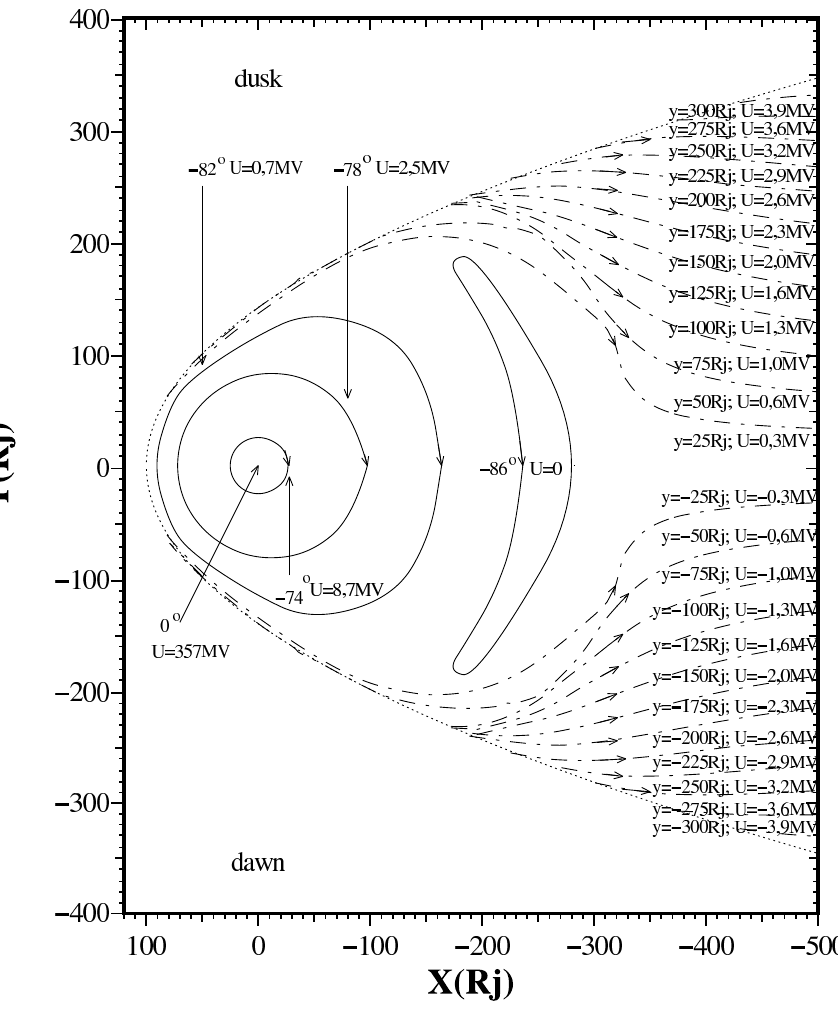
Fig. 12. Equatorial projection (solid curves) of lines of constant ionospheric latitude (the corotation electric equipotentials). The dash-dotted curves are the equatorial projections of the solar wind electric equipotentials y = const with steps δy = 25 R J ; δU = 0 . 3 MV. The dotted curve marks the magnetopause.